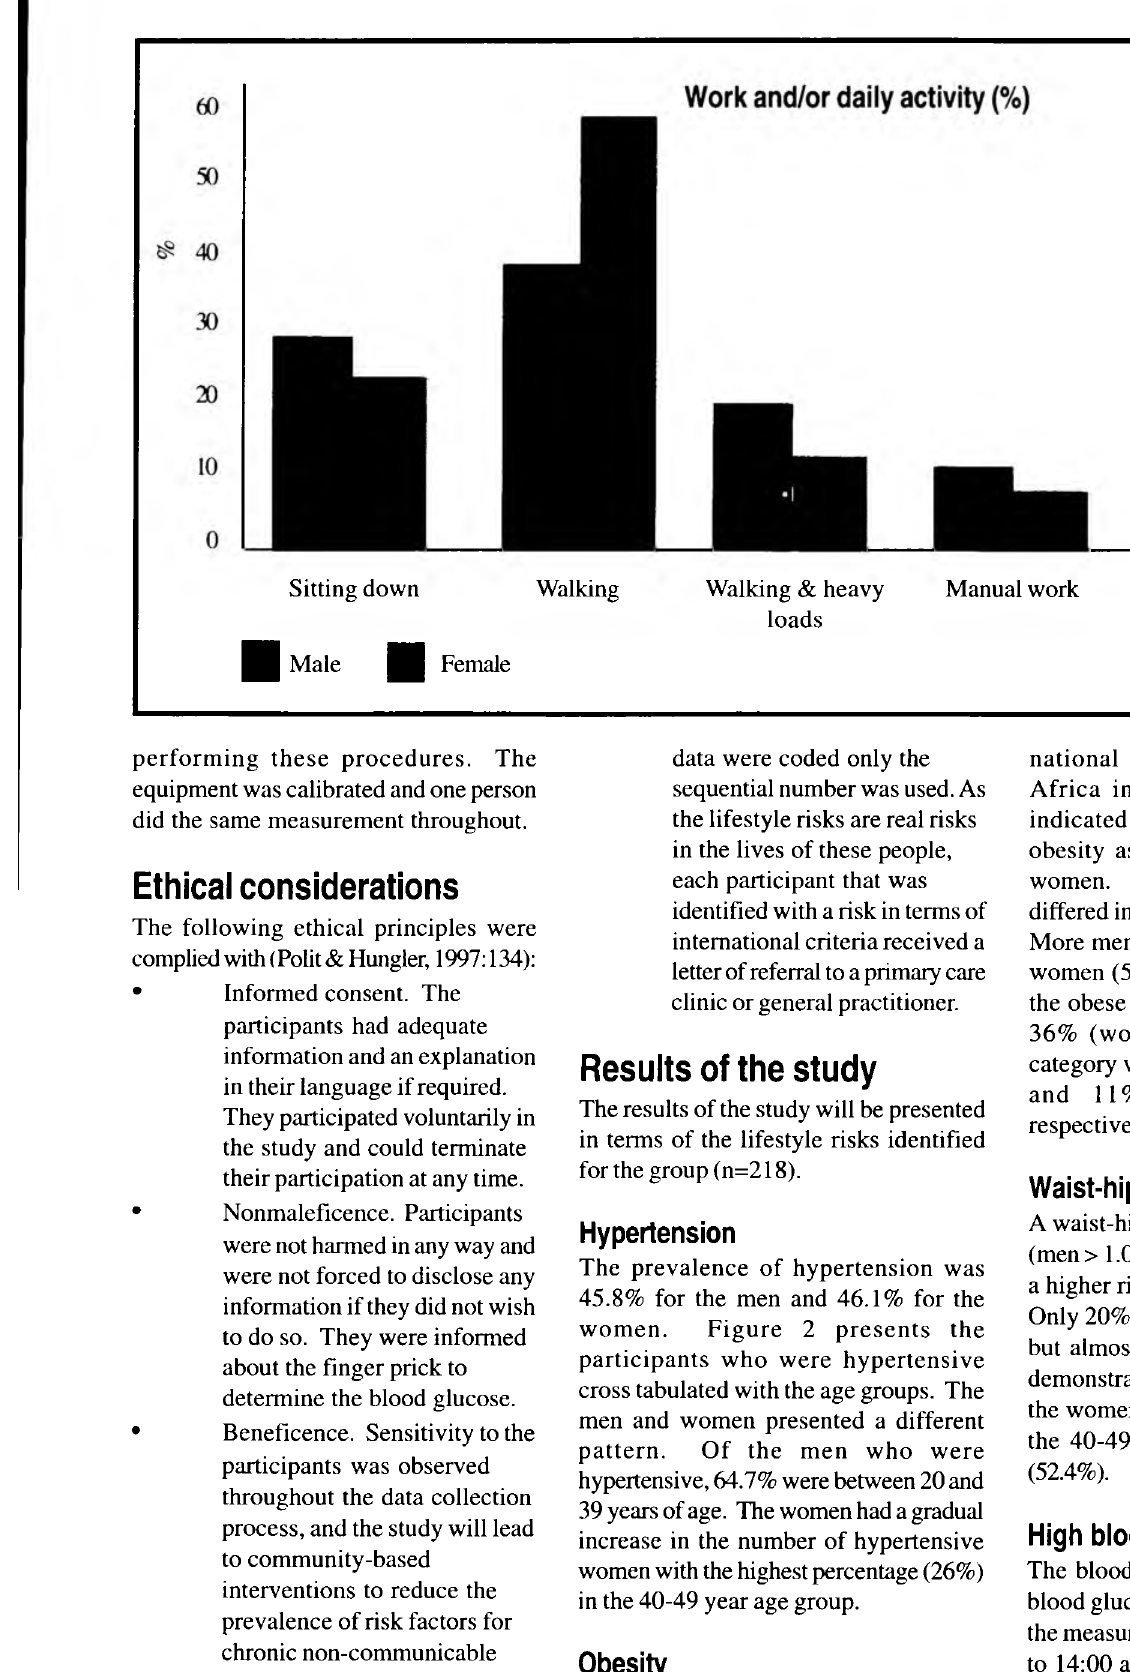
FIGURE 4: Participants’ work and/or daily activity (%) (n=218)